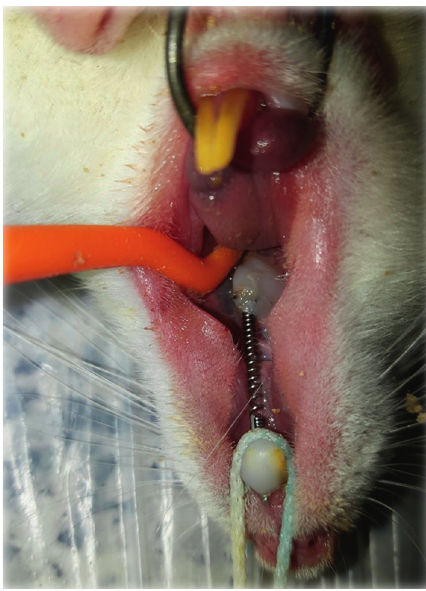
Figure 1: Nickel-titanium closed coil spring installed between the first molars and central incisors.